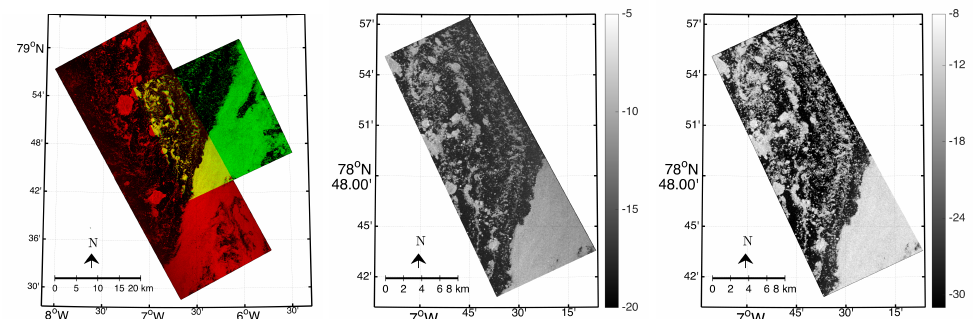
Figure 2. The left red-green-blue (RGB) composite image (scaled) of scene pair P 1 , where the green band is the intensity of the linear vertical transmit and linear vertical receive channel (VV) from Radarsat-2 (RS-2) scene and red is the intensity of the right-hand circular transmit and vertical receive channel (RV) from RISAT-1 (RI-1) scene. Yellow indicates areas of overlap. The center (right) image is the RV (VV)-intensity of the overlapping area from RI-1 (RS-2). RS-2 Data and Products c (cid:13) MDA LTD